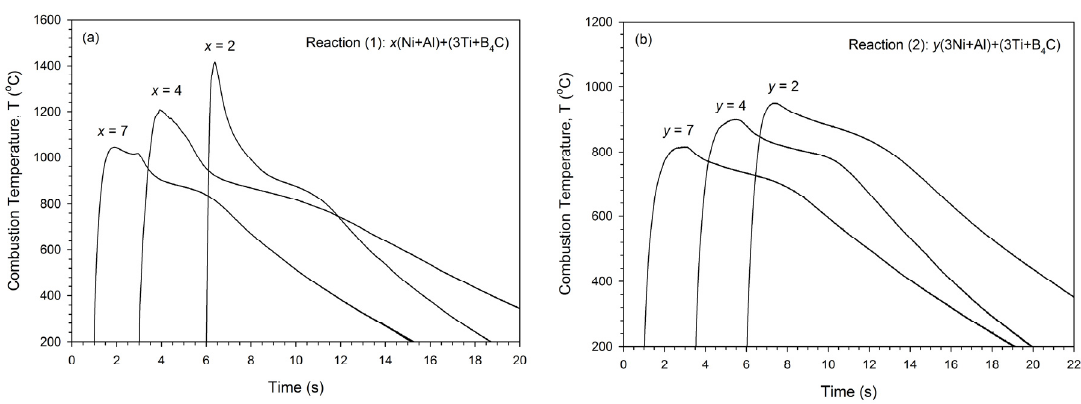
Figure 3. E ff ects of Ni and Al contents on combustion temperatures of ( a ) Reaction (1) and ( b ) Reaction